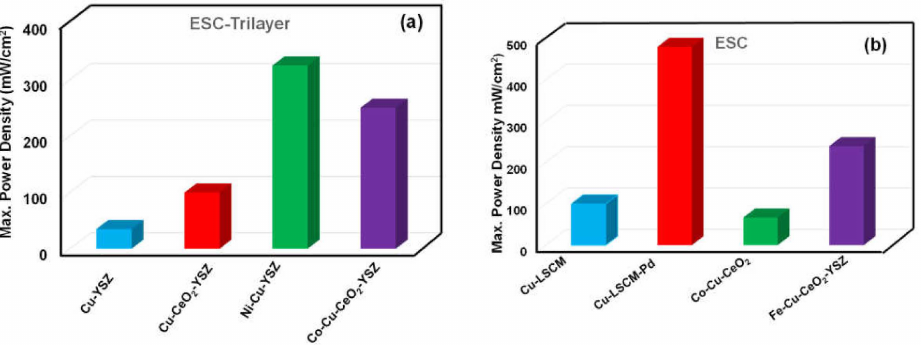
Figure 13. Bar graph showing the maximum power density of SOFCs fabricated from Cu-cermet anodes ( a ) using single, bi-layer, and tri-layer infiltration and ( b ) in ESC